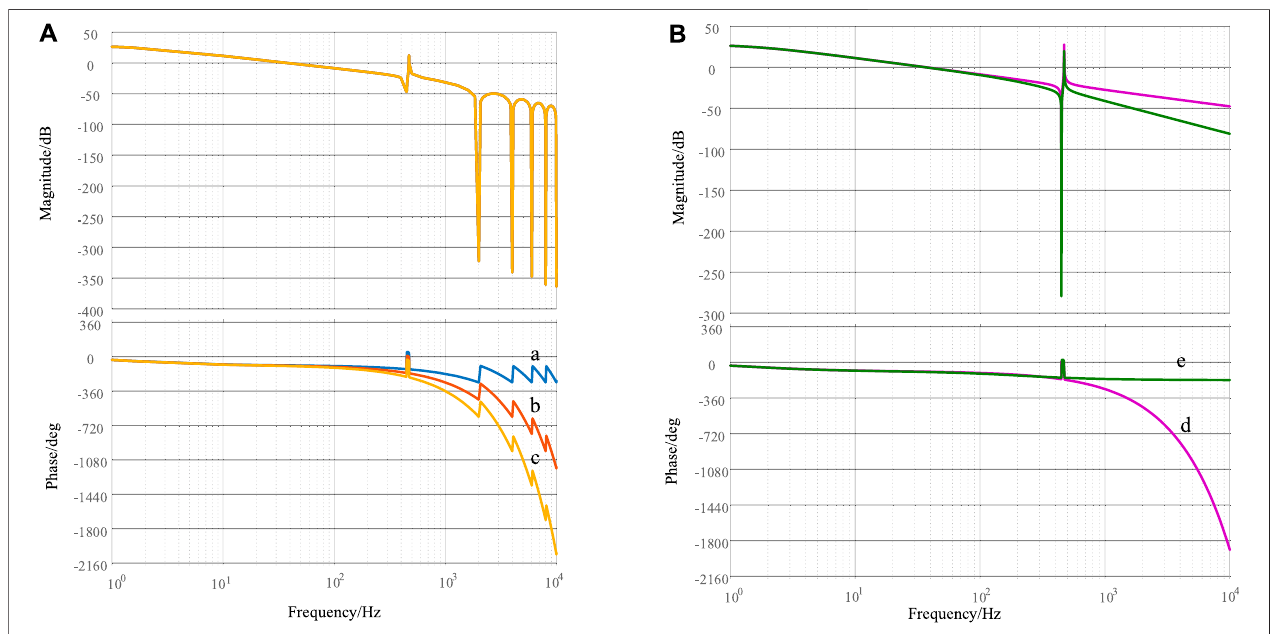
FIGURE6| Thebodediagramsoftheopen-loopgain (A) withdifferentdelayelementsand (B) without/withDPWMdynamics:(a)onlytheZOHelement(b)theZOH element and the calculation delay of 0.5 T s (c) the ZOH element and the calculation delay of T s (d) only the calculation delay of T s (e) only the inertial element as the PWM